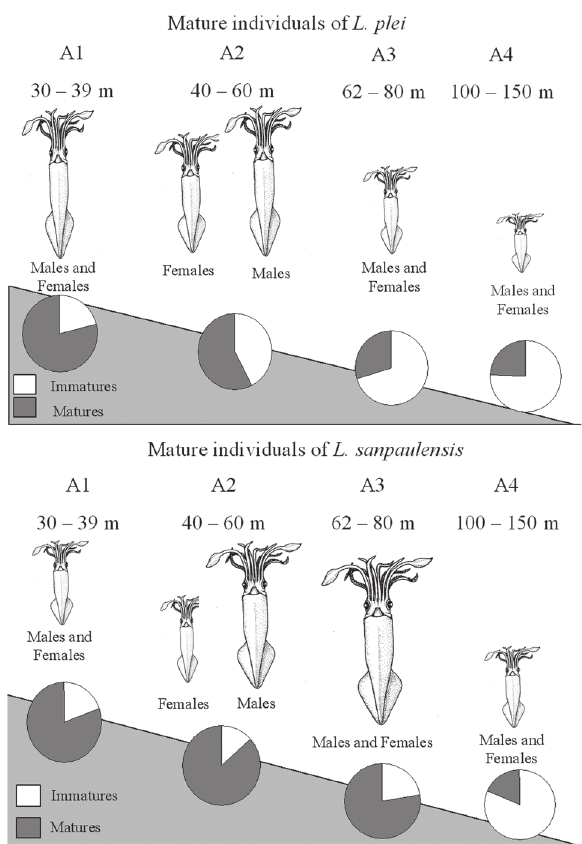
Fig. 6 . – Schematic representation of differences in size of mature squids and frequency of mature and immature individuals by depth strata in L. plei and L. sanpaulensis .